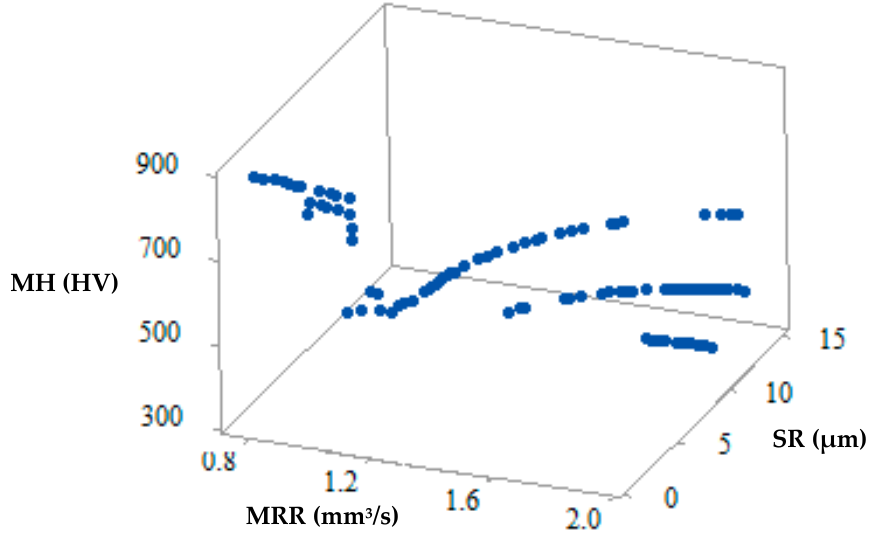
Figure 11. 3D Pareto curve of MRR vs. SR vs. MH.